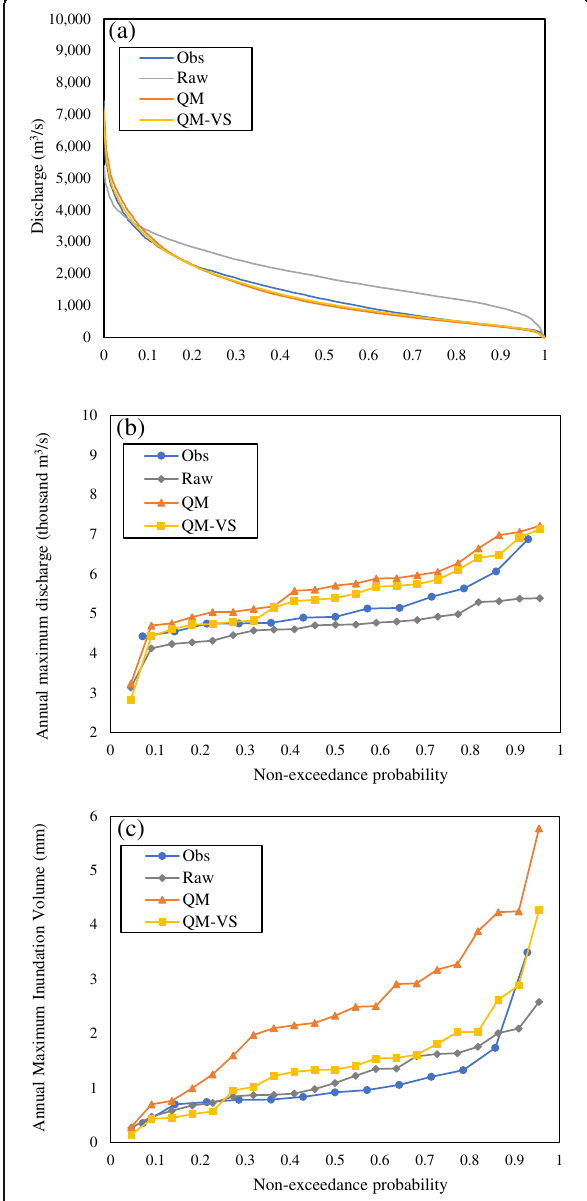
Fig. 8 Effects of bias corrections on hydrological variables.